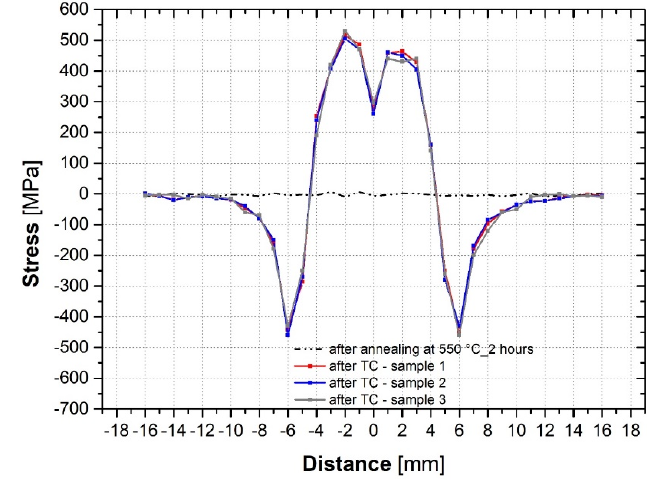
Figure 9. Courses of residual stresses after application of temperature cycles, for sample 1 (red curve), for sample 2 (blue curve), for sample 3 (grey curve).